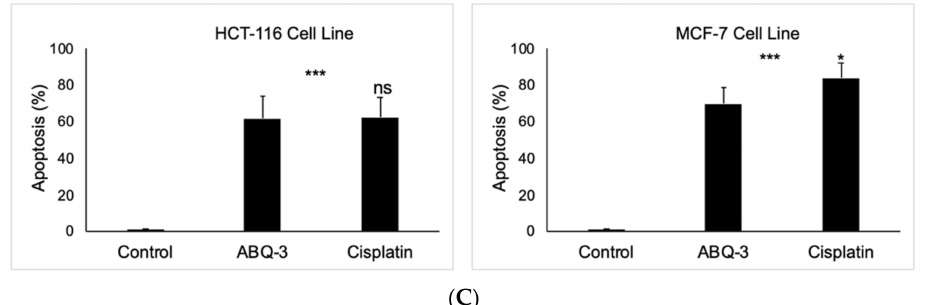
Figure 6. The changes that appeared in HCT-116 and MCF-7 cells after treatment with the control, ABQ-3 , and cisplatin ( A ) for 12 h. ( B ) A total of 100 randomly selected stained cells were analyzed in each experiment to define the percentage of apoptotic (green), late apoptotic/necrotic (yellow), and necrotic (red) cells ( C ) ***: denotes significant difference from control at p < 0.001, *: denotes significant difference from ABQ-3 at p < 0.05, ns: denotes no significant difference between ABQ-3 and cisplatin. The effect of the control (solvent) is below 1%, and this effect is excluded from the effect of molecules ( ABQ-3 and cisplatin) in ( B ) but is shown in ( C ).